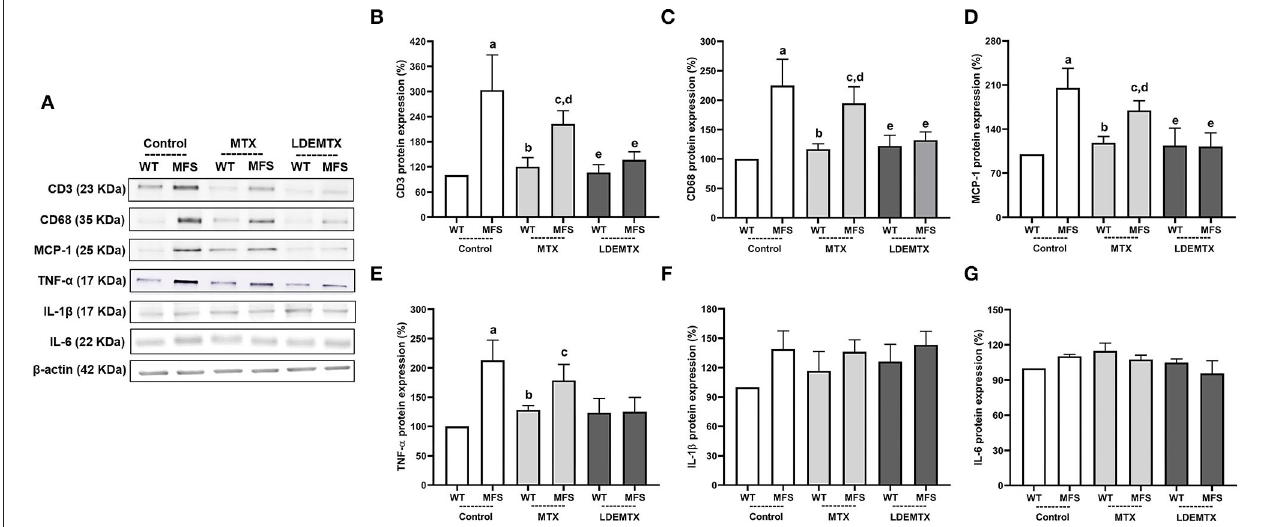
FIGURE 3 | Representative bands (A) and graphs showing western blot analysis of a number of inflammatory cells T lymphocyte (CD3) (B) and macrophages (CD68) (C) , the chemokine monocyte chemoattractant protein - 1 (MCP-1) (D) , and the cytokines proinflammatory tumor necrosis factor- α (TNF- α ) (E) , interleukin (IL)-1 β (F) , and IL-6 (G) protein expression in WT and MFS mice at 6 months of age, treated with MTX and LDEMTX. Values were normalized for the expression of β -actin and results were expressed as a percentage of WT WT-control group means. Data are means ± SEM of a pool of aorta segments, comprising ascending aorta, aortic arch, and descending aorta ( n = 5, per group). (a) p < 0.01 vs. WT-control; (b) p < 0.01 vs. MFS-control; (c) p < 0.05 vs. WT-control; (d), p < 0.05 vs. WT-MTX; and (e) p < 0.05 vs. MFS-control.